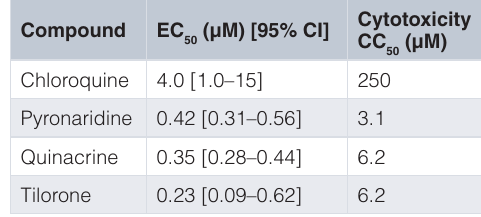
Table 2. Effect of drug treatment on infection with Ebola-GFP (n=3 per compound). The cytotoxicity of compounds are represented as a 50% cytotoxicity concentration (CC ) estimated by the lowest 50 concentration of drug that produced ≥ 50% loss in cell number by nuclei counting.